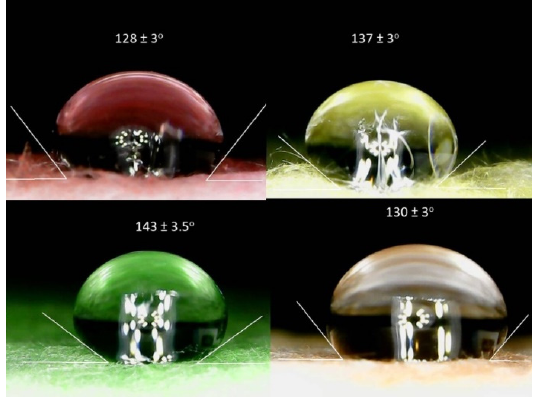
Figure 6. Hydrophobic tests of the samples.